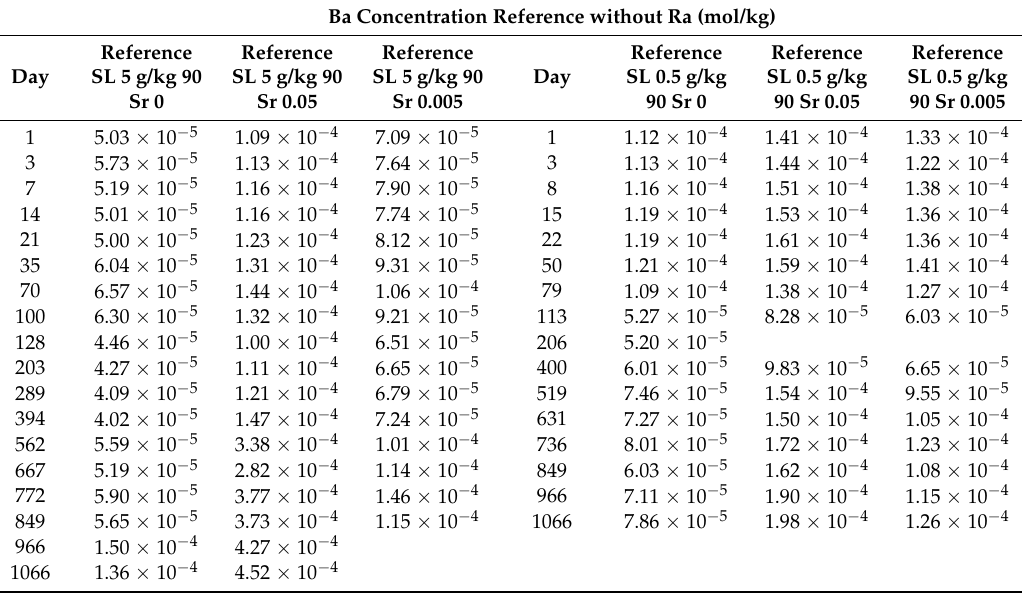
Table A9. Ba concentration of Reference experiments with Sr in the aqueous solution of at 90 ◦ C. Ba Concentration Reference without Ra